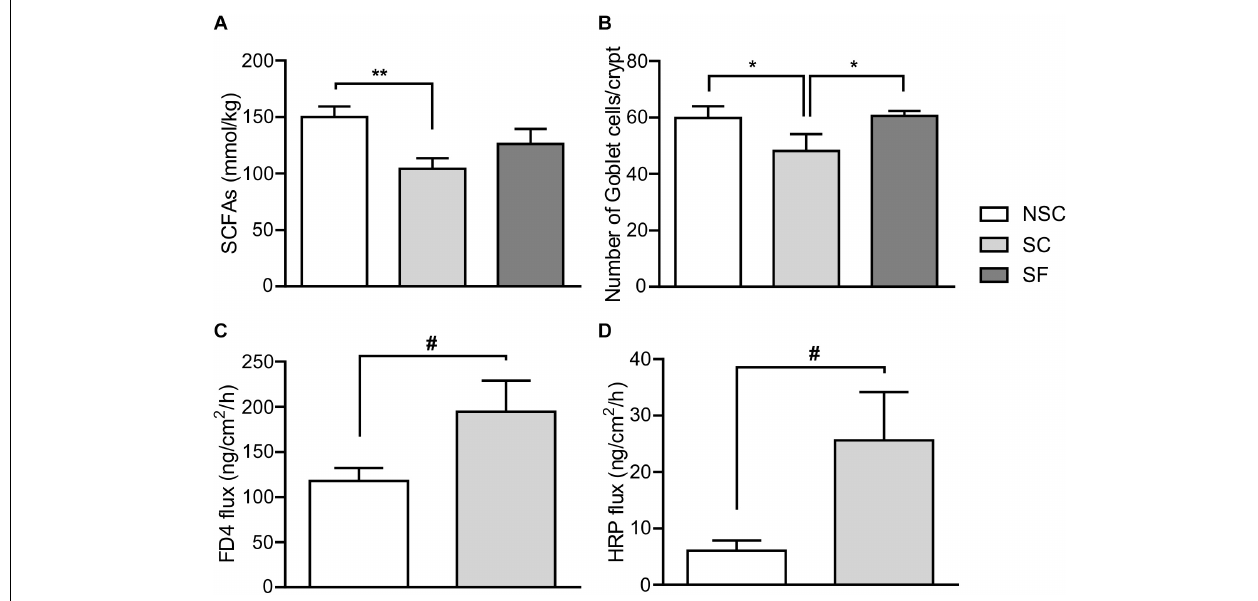
FIGURE 7 | Gut microbiota and physiology. At Week 3 the total quantity of SCFAs (A) was significantly lower in stressed (SC) than in non-stressed (NSC) animals [ F (2,18) = 4.397, p = 0.008]. Treated-stressed (SF) animals did not differ from SC and NSC. N = 7–9/group. The number of goblet cells per crypt in SC was significantly lower in the jejunum compared to NSC and SF [ F (2,17) = 7.729, SC/NSC: p = 0.011, SC/SF: p = 0.008] (B) . N = 8/group, mean ± SEM, two-way ANOVA. After 8 weeks of stress, permeability tended to be higher in SC compared to NSC: paracellular permeability in colon, F (1,20) = 3.956, p = 0.061, n = 12/group, (C) ; transcellular permeability in jejunum, F (1,19) = 4.311, p = 0.052, n = 11–12/group, (D) , Mean ± SEM, one-way ANOVA, # p < 0.1, ∗ p < 0.05, and ∗∗ p <